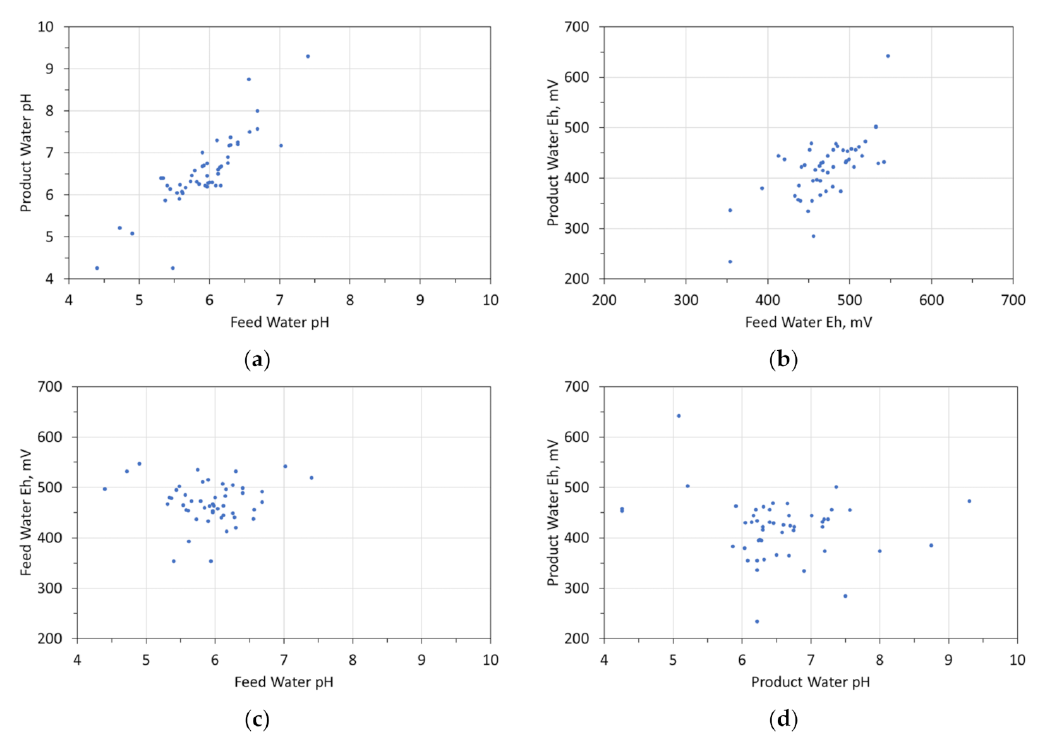
Figure A4. Redox parameters. ( a ), Feed water pH versus product water pH; ( b ), Feed water Eh versus product water Eh; ( c ), Feed water pH versus feed water Eh; ( d ), Product water pH versus product water Eh.